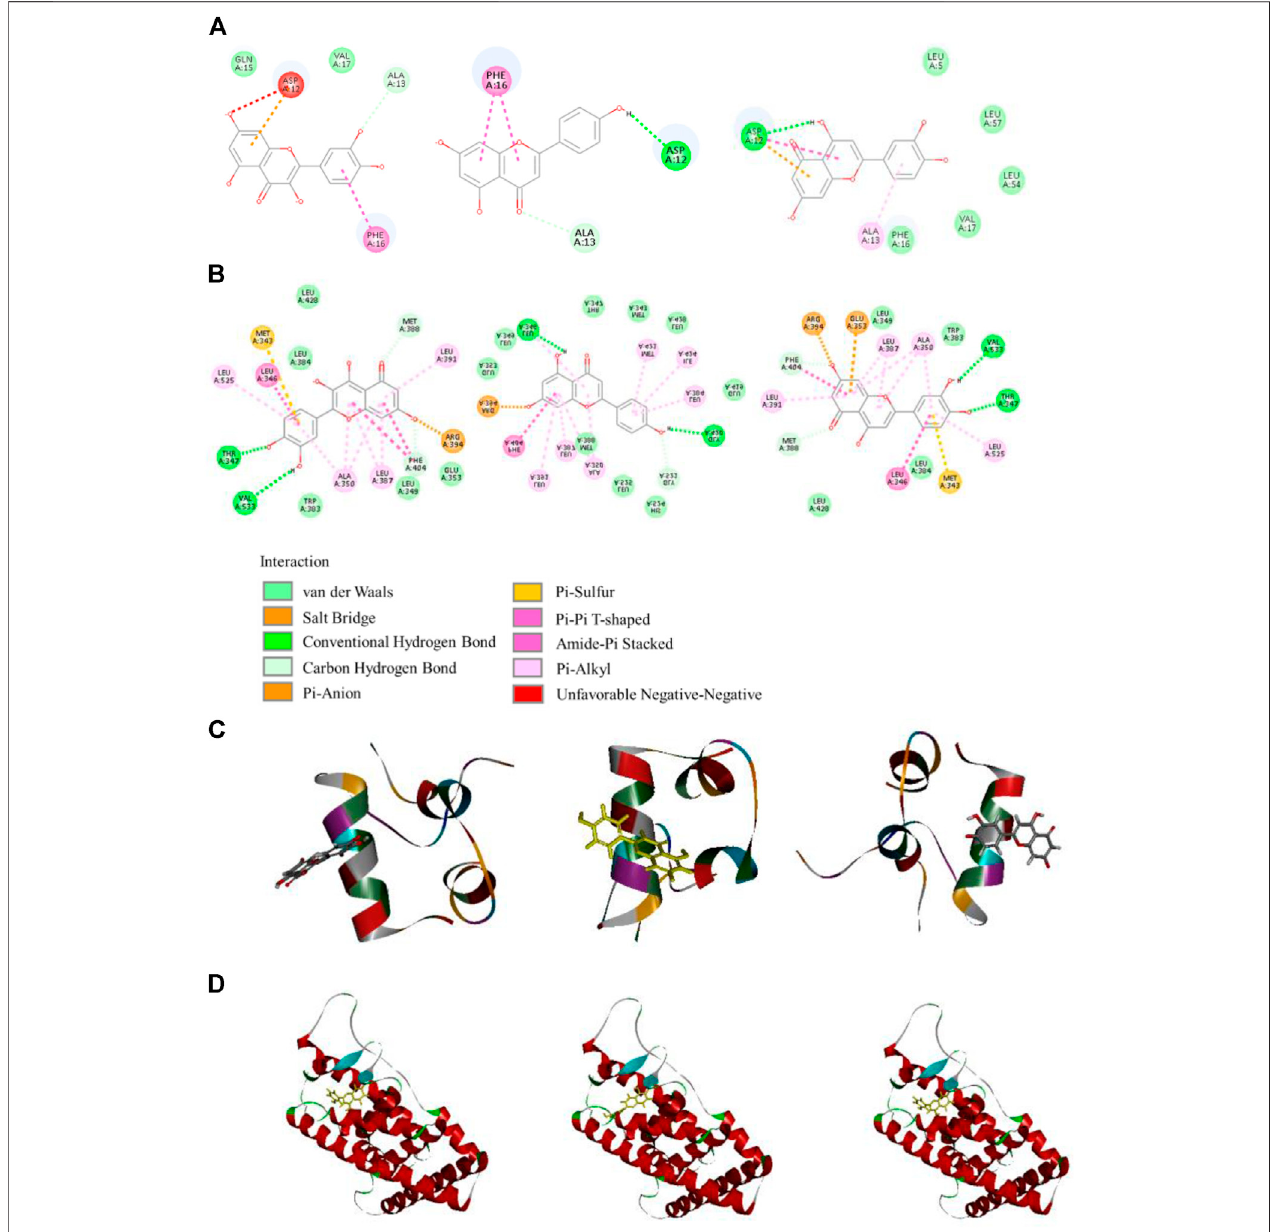
FIGURE3|(A) ActivebindingsitesofcompoundswithIGF1. (B) ActivebindingsitesofcompoundswithESR1. (C) Moleculardockingpatternsofcompoundsand IGF1. (D) Molecular docking patterns of compounds and